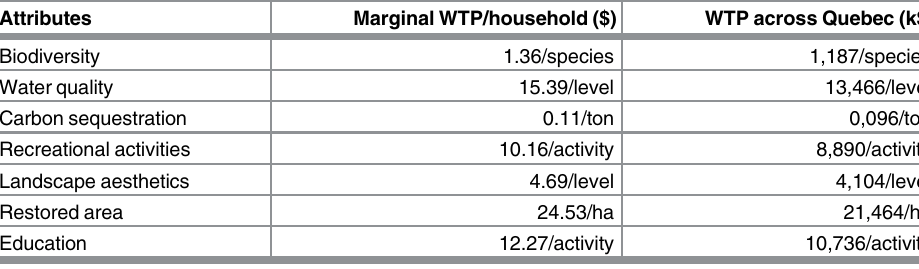
Table 4. Marginal willingness to pay per household aggregated across Quebec